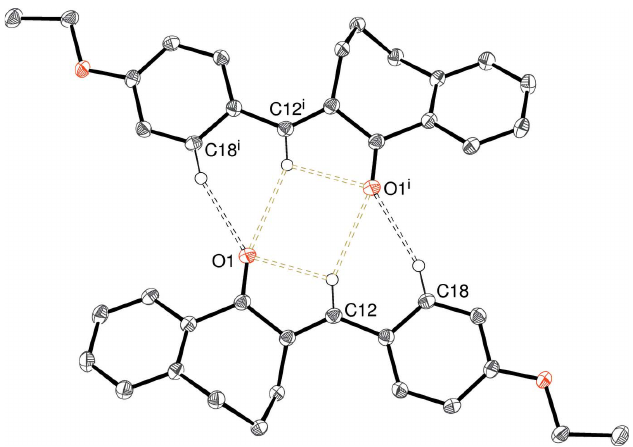
Figure 8 Fragment of the crystal structure of (II), showing inversion dimers linked by pairs of C18—H18 (cid:3)(cid:3)(cid:3) O1 hydrogen bonds. [Symmetry code: (i) (cid:6) x + 1, (cid:6) y + 1, (cid:6) z + 1.]